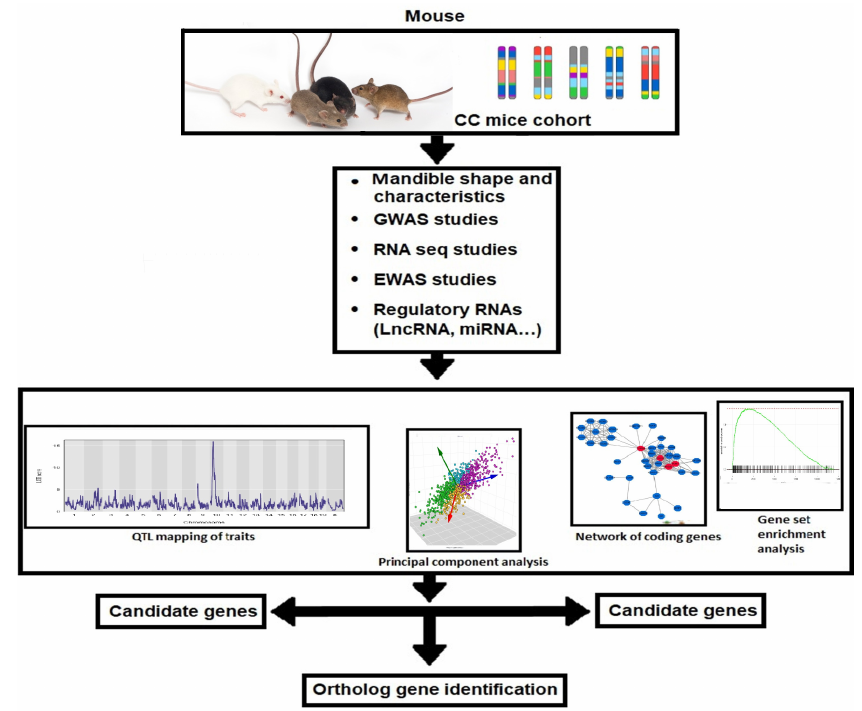
Figure 2. Workflow for the creation of system genetic databases from the CC population, which is incredibly heterogeneous and may have vastly different susceptibilities to class III malocclusion. Class II and III malocclusion in mice is checked. The analysis of numerous associations between malocclusion and class III traits uses cellular, molecular, and clinical trait data. The regulatory genomic areas are implicated in phenotypic variance in both in vitro and in vivo monitored traits when SNP genotype data from each CC lineage are combined. Combining data with later candidate gene association research in humans may help find susceptibility genes linked to the emergence of class III malocclusion in people.